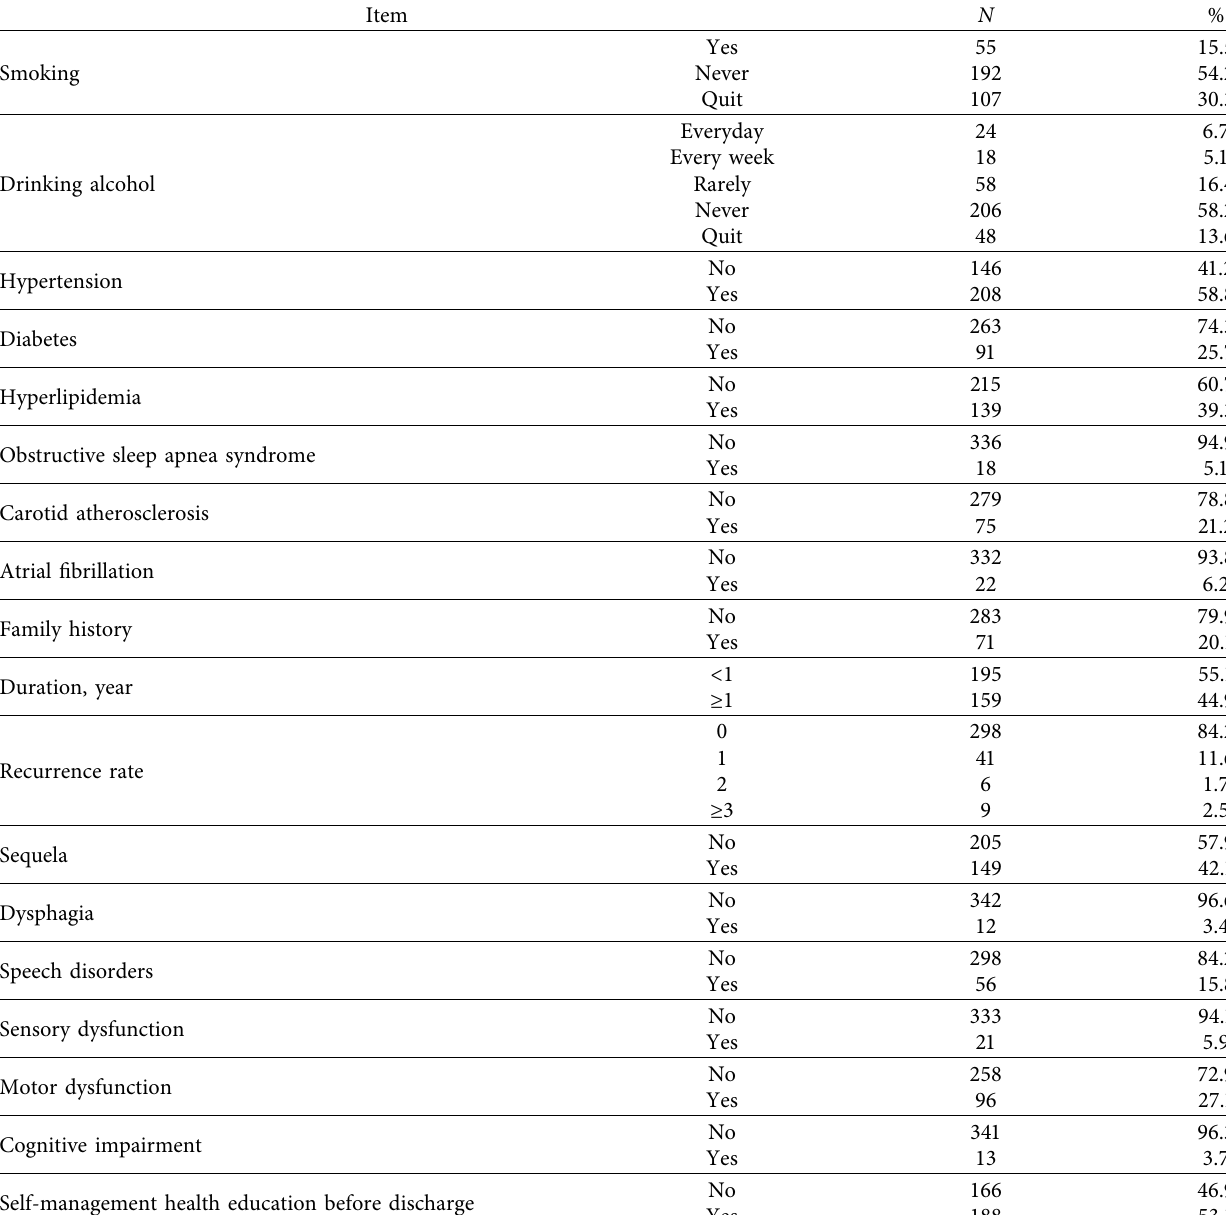
Table 2: Clinical characteristics of the 354 efective